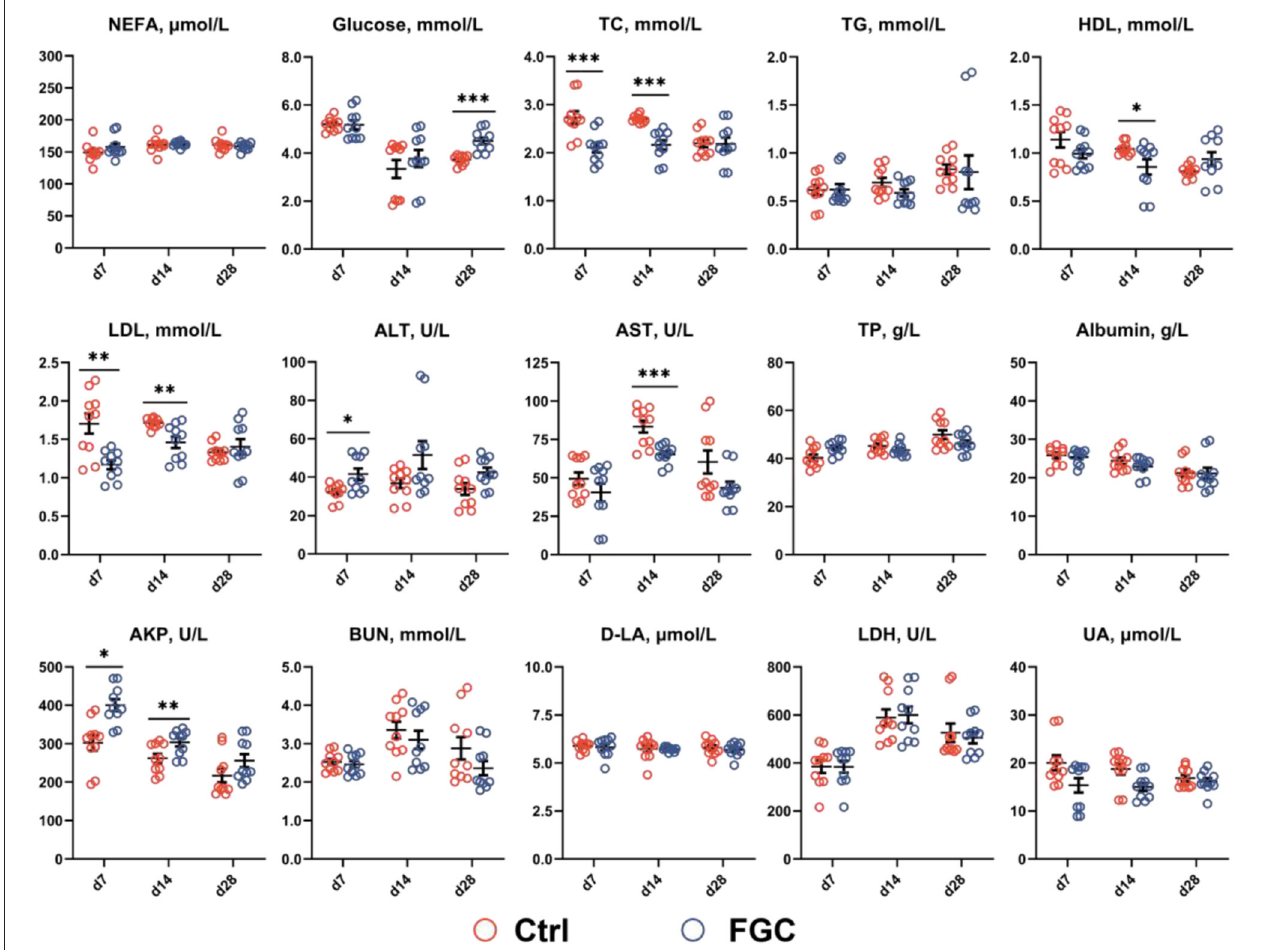
FIGURE 1 | Serum metabolites of 7d, 14d and 28d-piglets as affected by dietary ferrous glycine chelate supplementation. NEFA, non-esterified fatty acids; TC, total cholesterol; TG, total triglycerides; HDL, high density lipoprotein; LDL, low density lipoprotein; ALT, alanine aminotransferase; AST, aspartate aminotransferase; TP, total protein; AKP, alkaline phosphatase; BUN, blood urea nitrogen; D-LA, D-lactate; LDH, lactate dehydrogenase; UA, uric acid. Ctrl, corn-soybean basal diet; FGC, corn-soybean basal diet with 2,000 mg/kg ferrous glycine chelate. Data were shown as means ± SEM. * p < 0.05; ** p < 0.01; *** p < 0.001. N = 10.